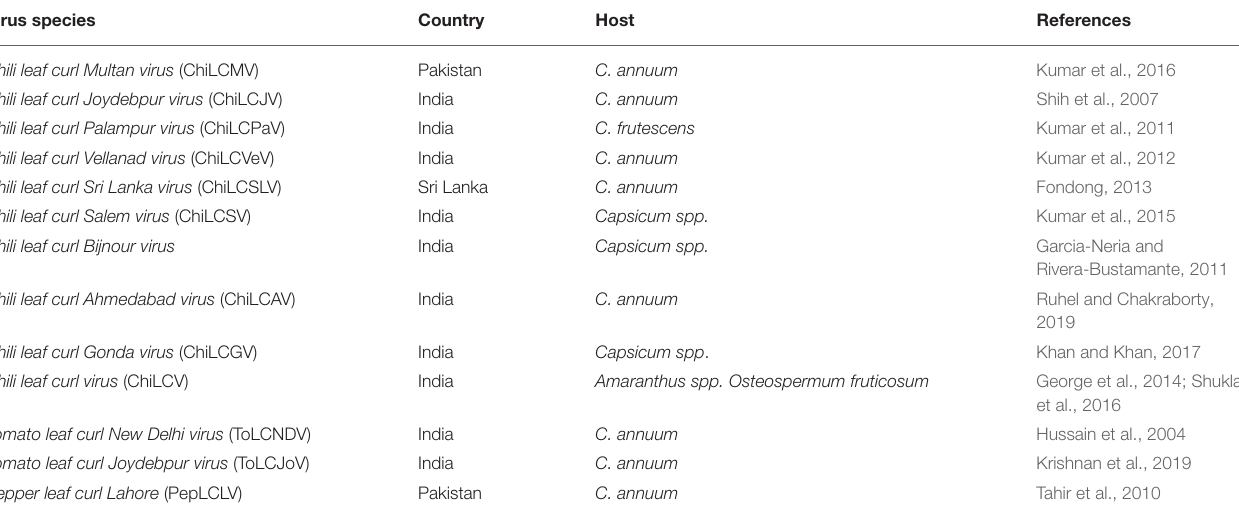
( Supplementary Figure 1 ). In India, ChiLCV associated with ChiLCD is distributed in different states viz ., West Bengal, Bihar, Haryana, Delhi, Rajasthan, Uttar Pradesh, Himachal Pradesh, Goa, Gujarat, and Maharashtra (Kumar et al., 2015). Looking toward the devastating and widespread nature of the virus, it must be restricted to the infected regions only and should not spread to other parts of the globe. Worldwide efforts are being made toward understanding of nature of the virus and its economic importance and the development of resistant sources by means of conventional and non-conventional